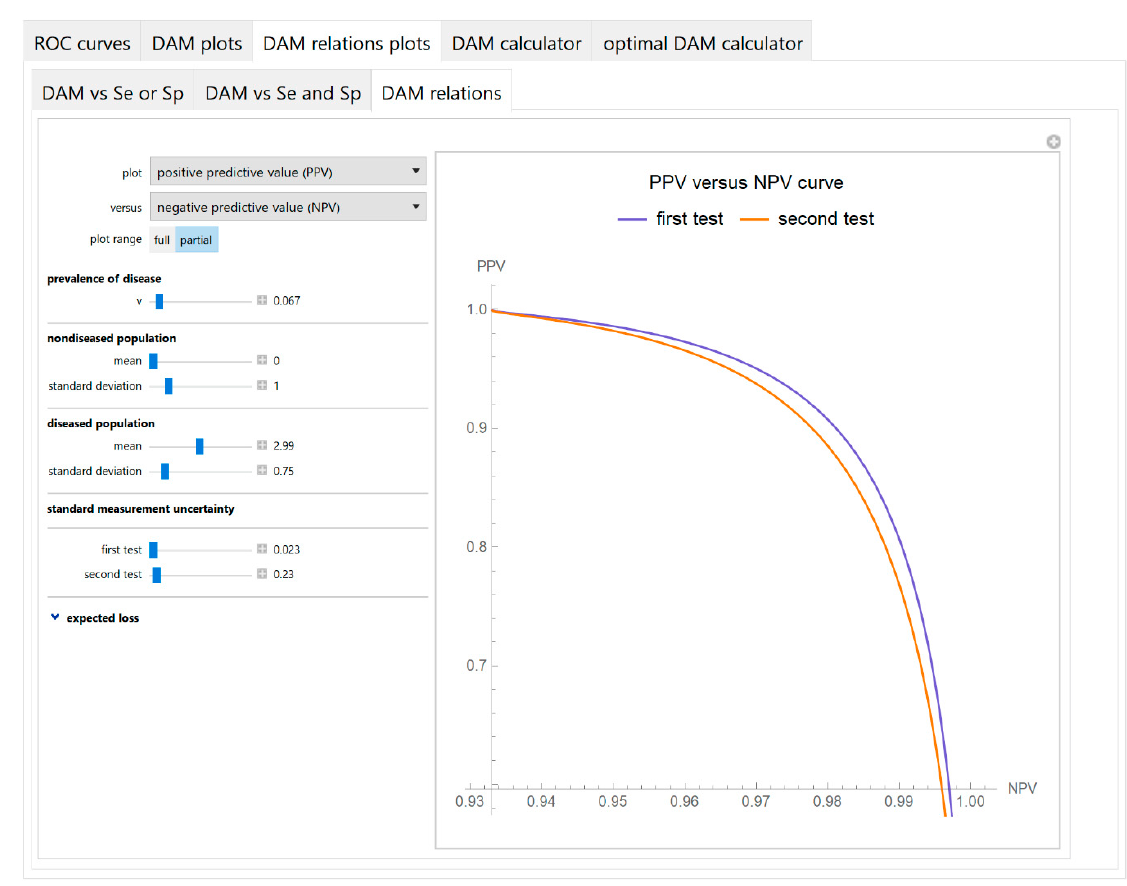
Figure 8. DAM relations plots module, DAM against sensitivity and specificity submodule screenshot. Likelihood ratio for a positive test result (LR + ) of two screening or diagnostic tests measuring the same measurand with different uncertainties, against sensitivity ( Se ) and specificity ( Sp ) curves plot, with the settings shown at the left.